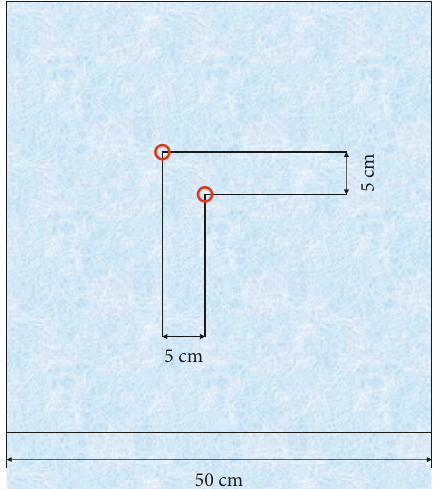
Figure 8: Schematic diagram of temperature measurement center point T